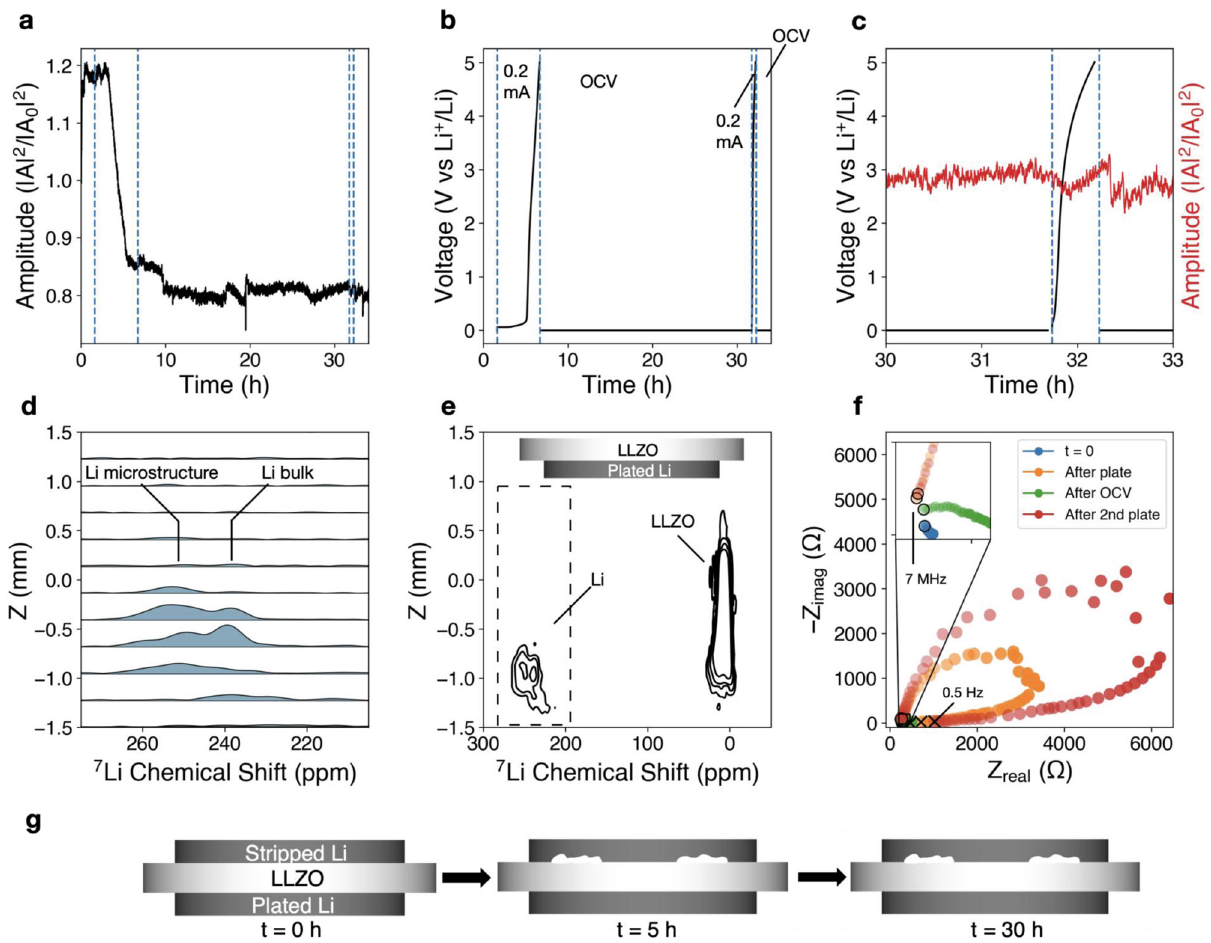
Fig. 2 Lithium metal – LLZO interface at 2 MPa. Polarization test of Li (s) – LLZO interface at 2 MPa stack pressure conducted in a Li/LLZO/Li cell. After a few hours of initial mechanical equilibration, 0.2 mA/cm 2 is applied galvanostatically until the voltage cutoff of 5 V, followed by a 25 h OCV rest step, a second polarization step in the same direction, and a second OCV rest step. a Normalized acoustic amplitude (intensities relative to fi rst waveform intensity). b Voltage showing increase in overpotential to voltage cutoff during the fi rst galvanostatic current step of 0.2 mA/cm 2 , and rapid overpotential increase during the second step. Vertical guidelines (dotted blue lines) are shown as a visual aid to delineate start and stop of galvanostatic current. c Voltage and amplitude curves zoomed in on the second polarization region. d 1D slices of the ex situ 7 Li chemical shift imaging (CSI) experiment in the z - direction highlighting the lithium metal region between 200 and 280 ppm, as indicated by the dashed region in e . e Contour plot of ex situ 7 Li CSI depicting a strong lithium metal resonance (~250 ppm) extending into the electrolyte region (0 ppm) in the z -direction. Stripped side is on top (positive z -direction) and the stripped foil at low stack pressures is missing because it immediately delaminates from the LLZO surface following disassembly. f Nyquist plot from potentiostatic EIS conducted during initial OCV, after the fi rst galvanostatic step, after the subsequent 25 h OCV hold, and after the second galvanostatic step, indicating an increase in cell impedance following the polarization steps and incomplete impedance recovery following the 25 h OCV step. The open circle indicates the high-frequency start point (7 MHz), and the cross indicates the low-frequency end point (0.5 Hz). g Simpli fi ed cartoon illustration of interface behavior (showing extent of contact loss and presence/absence of voids) implied by the experimental data; not drawn to inside the electrolyte ex situ (Fig. 2d, e). Lithium microstructure roughening, which appears despite the implementation of a long from either voids, uneven plating, or growth within the electrolyte rest step. The increased surface roughening observed after manifest as higher frequency 7 Li chemical shifts, compared to the polarization/repolarization is correlated with the acoustic ampli- native lithium metal electrode, due to differences in orientation tude attenuation without subsequent recovery. A similar or with respect to the external magnetic fi eld (i.e., bulk magnetic greater magnitude of surface roughening could be assumed for susceptibility effects, further explained in Supplementary the stripped side, which easily delaminated from the cell following Discussion 1.2) 36 . 7 Li CSI showed a strong microstructural signal disassembly, likely due to extensive void formation at the stripped Li (s) – LLZO interface. Analysis of the plated lithium – LLZO interface with 7 Li CSI shows new peaks at approximately − 1 and 8 ppm (Supplementary Fig. 3a, b), suggesting that LLZO decomposes and forms an electronically conductive interphase, which may have been caused by the voltage polarization and contribute to interfacial reactivity and poor impedance recovery Fig. 2e; individual slices from the CSI experiment are shown in between the fi rst and second Li plating steps (Fig. 2f). This is Fig. 2d. The CSI results are consistent with rapid surface supported by post-mortem EDS measurements that show a